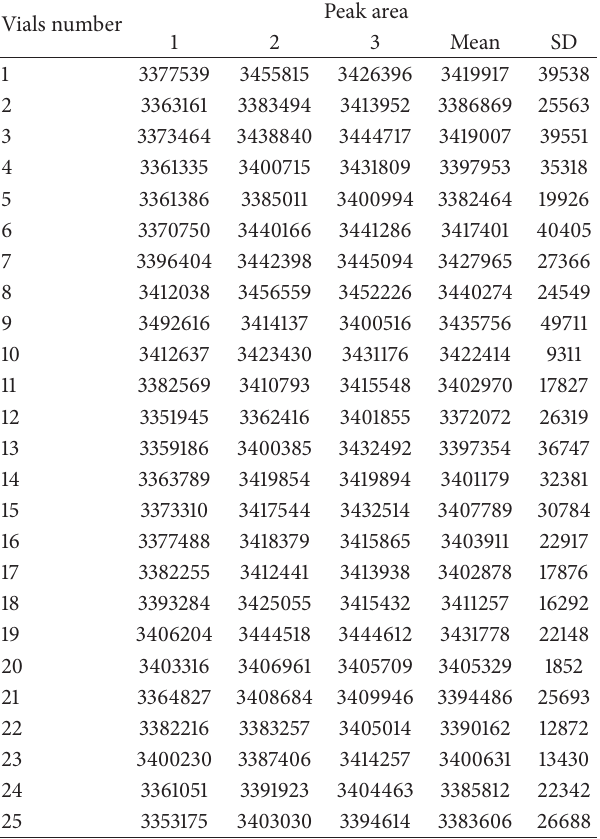
Table 3: Data of homogeneity study.